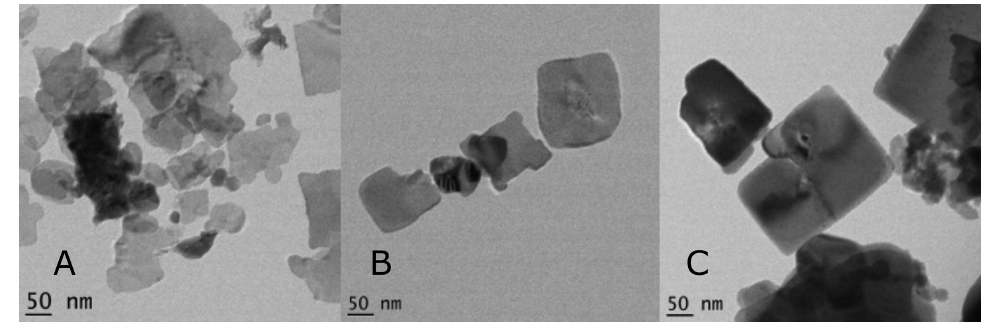
Figure 3 TEM recordings of BTO samples (A), (B) and (C) shows their sheet-like morphology. The thickness of the sheet increases depending on the PEG-6000 added before synthesis (A) having 0.02 g, (B) having 0.04 g and (C) having 0.06 g of PEG-6000 respectively. Sample A shows a mixture of sheets and agglomerated spheroids. The thickness of the sheets increase with the amount of PEG, showing the effect of the surfactant on the